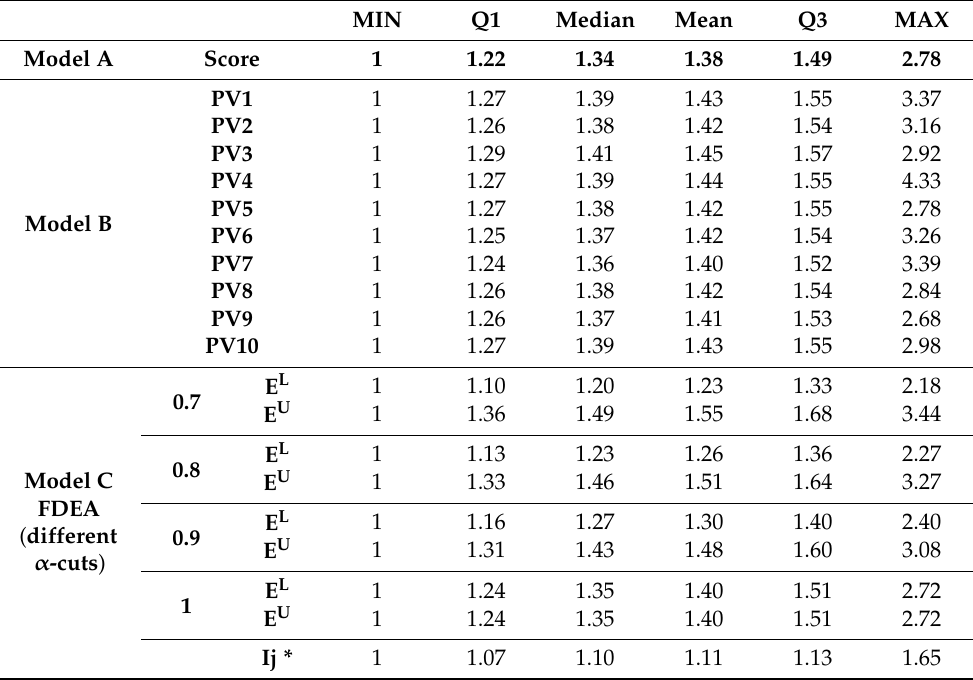
Table 4. Descriptive statistics of efficiency scores for different approaches. MIN